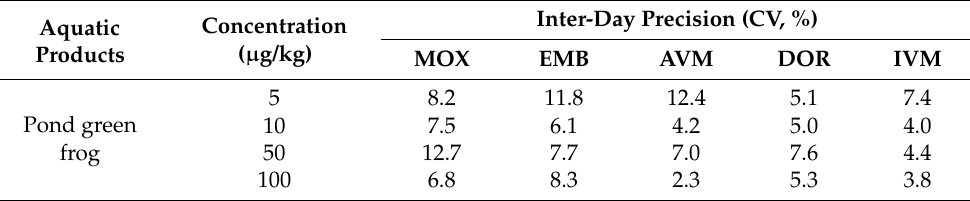
Table 8. Inter-day precisions of five AVMs in aquatic products (n =